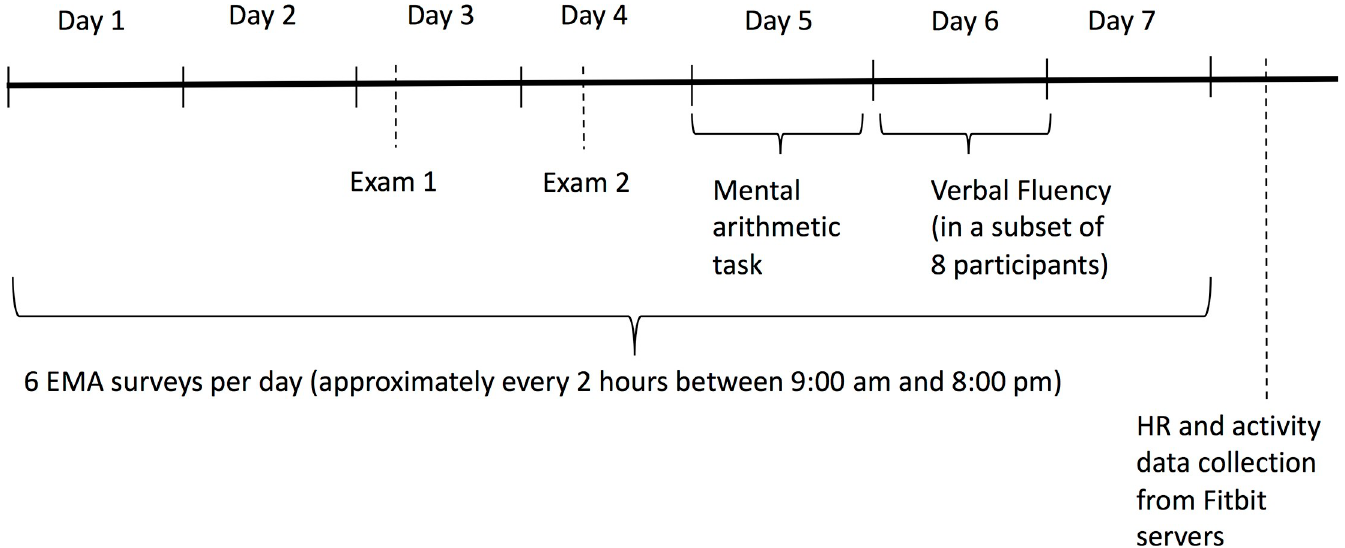
Fig 1. Study outline example for participants that had an exam on days 3 and 4 of the observation period.